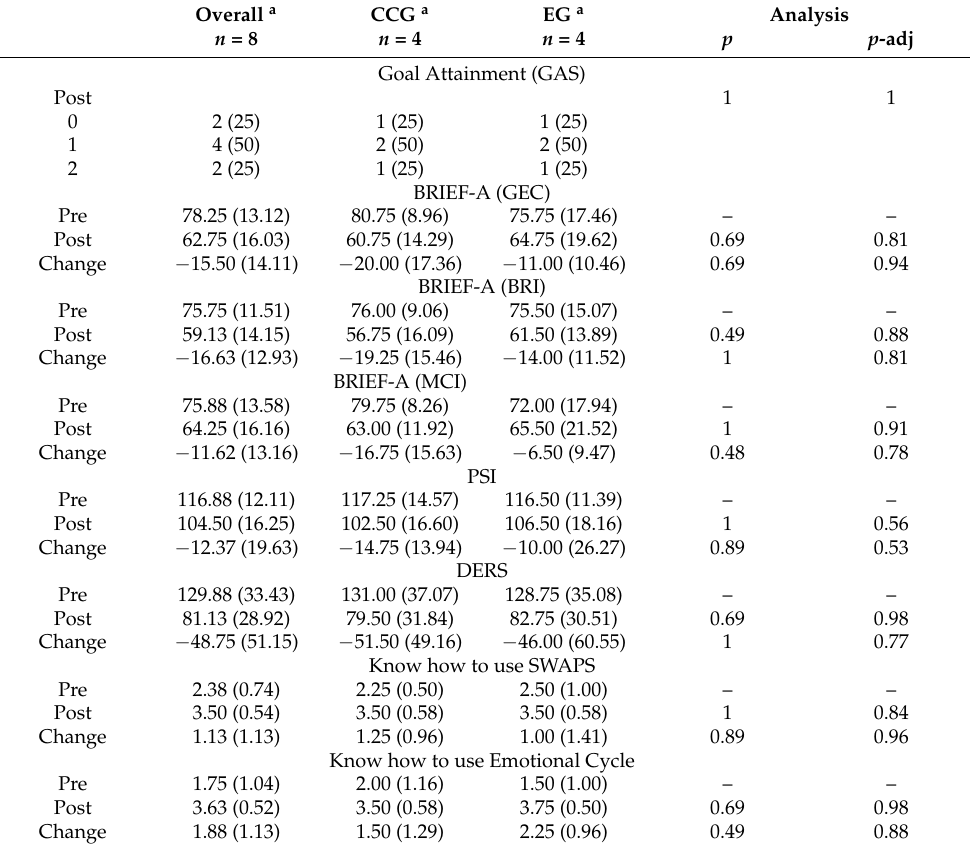
Table 5. Differences Between Groups for Outcome